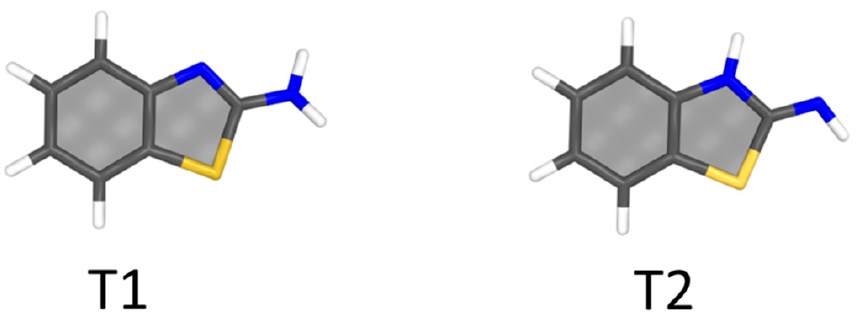
Figure 6. Quantum-chemically predicted conformations of T1 and T2. The relative electronic energy difference ∆ E rel = E (T2) − E (T1) is 5.4 kcal/mol in the gas phase and 5.6 kcal/mol in the implicit solvent when calculated with B3LYP/def2-TZVP/D3.